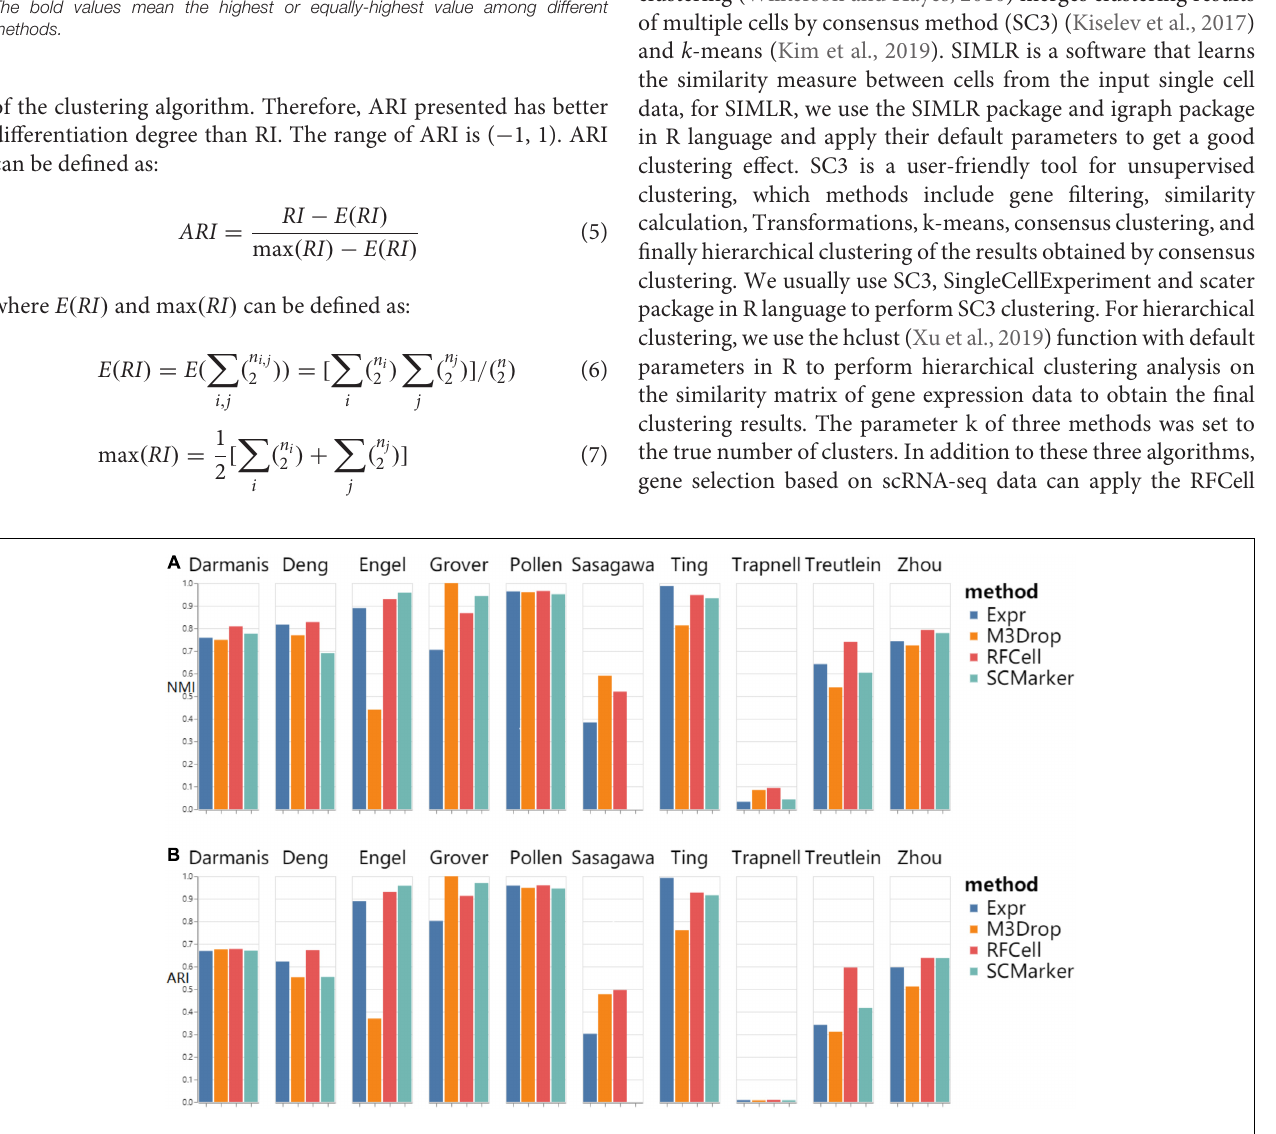
Frontiers in Genetics |